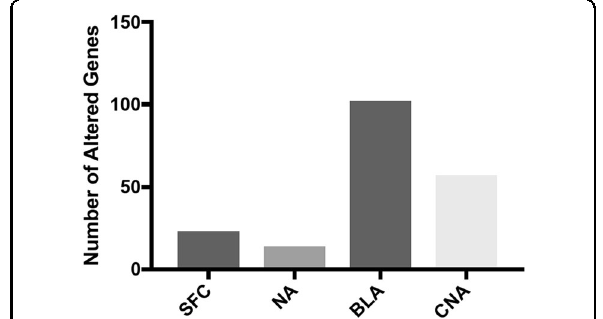
Fig. 1 Differentially expressed genes in brain regions of patients with alcohol use disorder. SFC superior frontal cortex, NA nucleus accumbens, BLA basolateral amygdala, CNA central nucleus of the